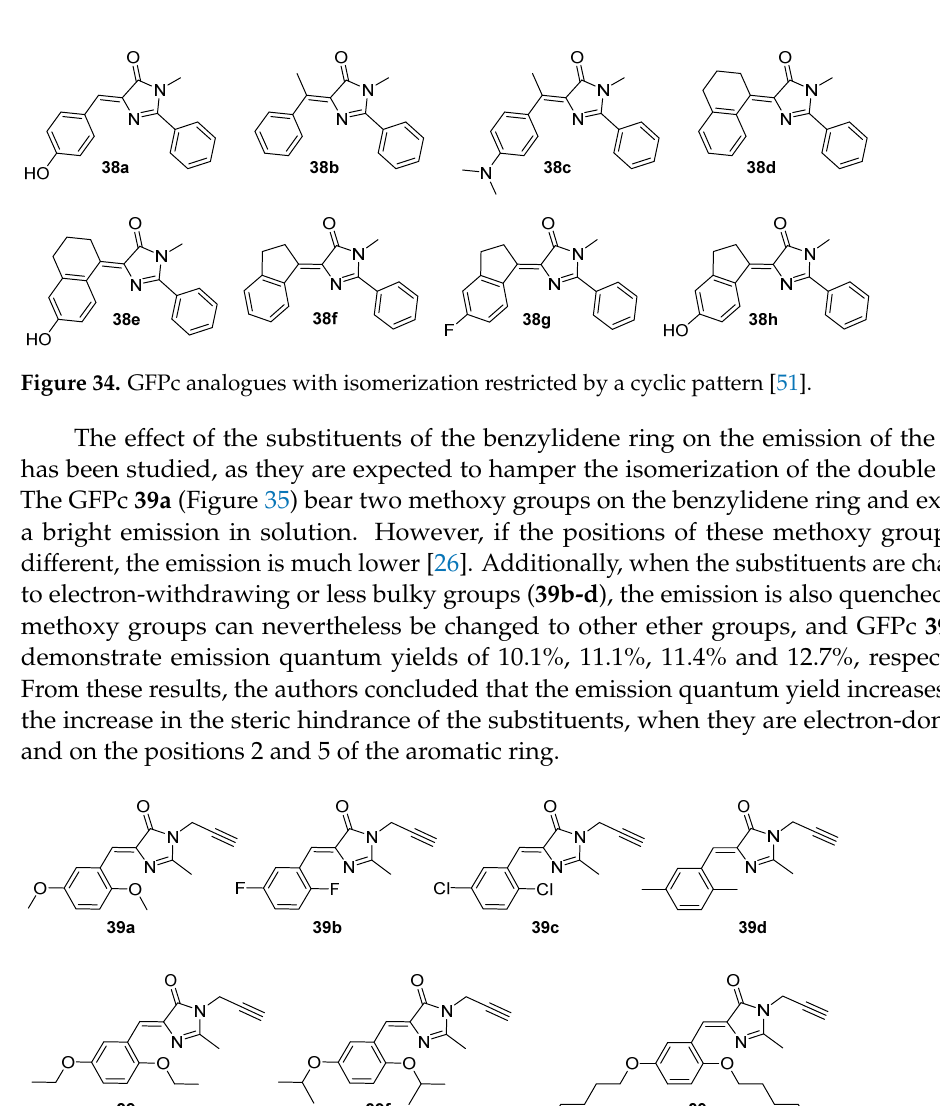
Figure 34. GFPc analogues with isomerization restricted by a cyclic pattern [51].